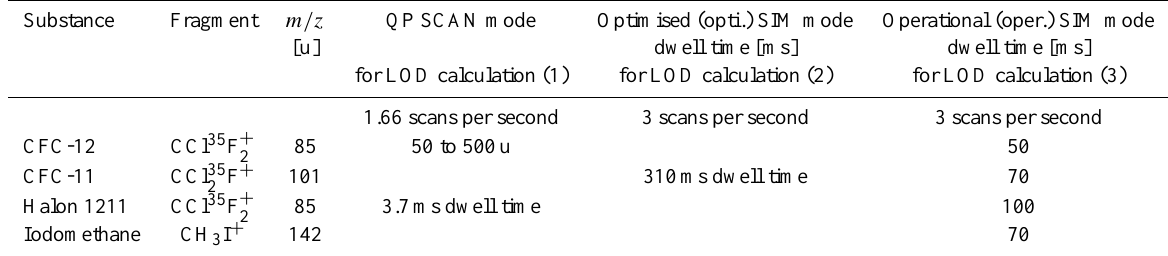
Table 2. Dwell time settings for given substance fragments in QP MS modes with a data frequency of ≈ 3Hz. SCAN mode (1): QP scanned from 50 to 500u with 1.66 scans per second and a dwell time of 3.7ms. Optimised (opti.) SIM mode (2): settings used for measurements on which LOD calculation was based, with 310ms dwell time per ion and a scan rate of 3 scans per second. Operational SIM mode (3): default settings, used for reproducibility and linearity experiments with 3 scans per second.